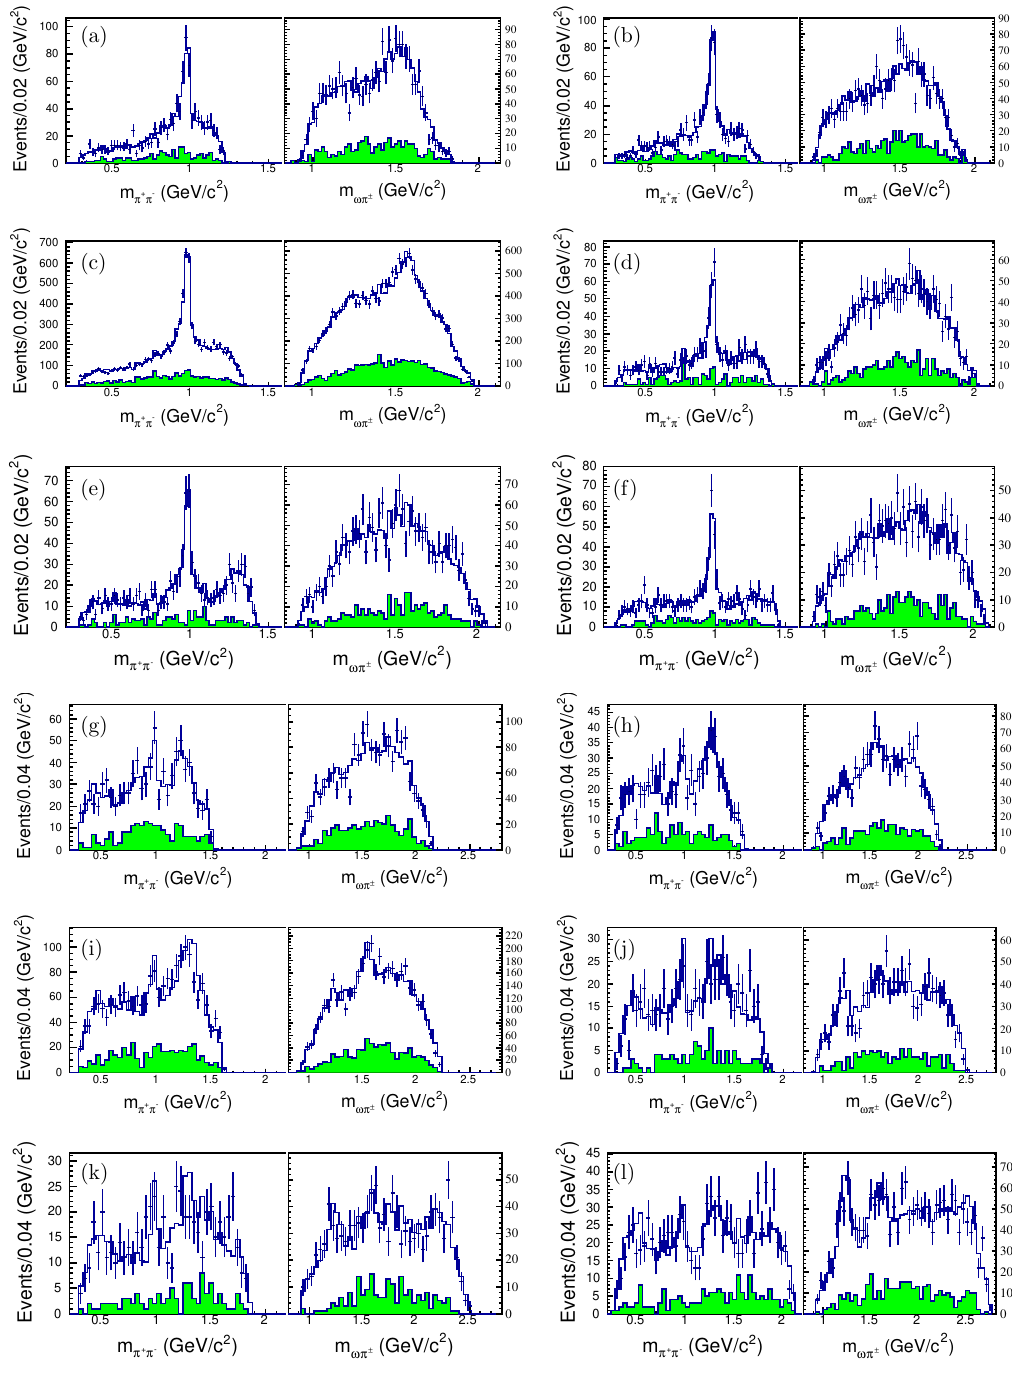
and m for se- π + π − ωπ ±